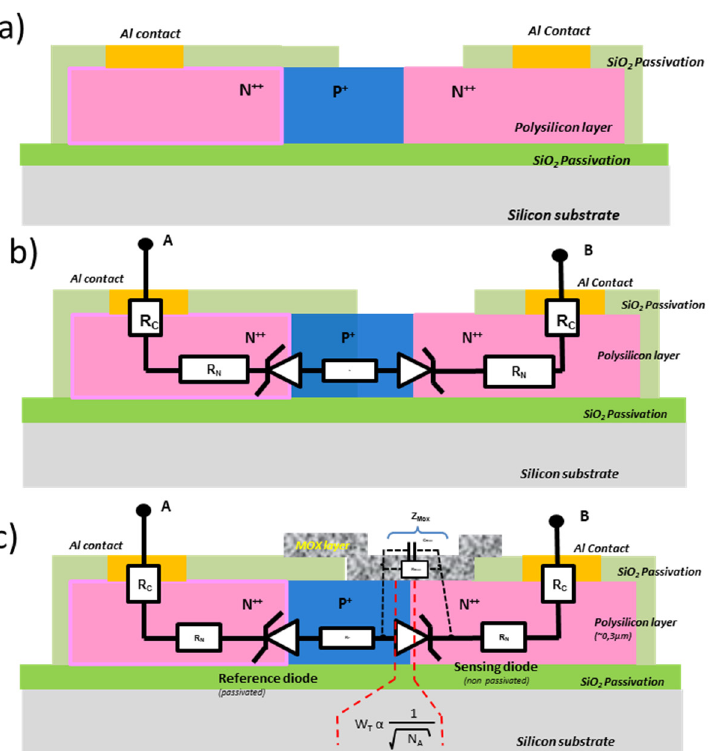
Figure 3. Basic cross section of Zener diode-based platform: ( a ) the overall structure of a single element; ( b ) the electrical equivalent circuit; ( c ) the electrical equivalent circuit after the sensitive MOX layer.